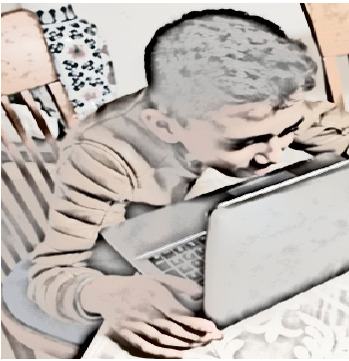
Figure 5. Adel (85) deeply looking at the computer screen.